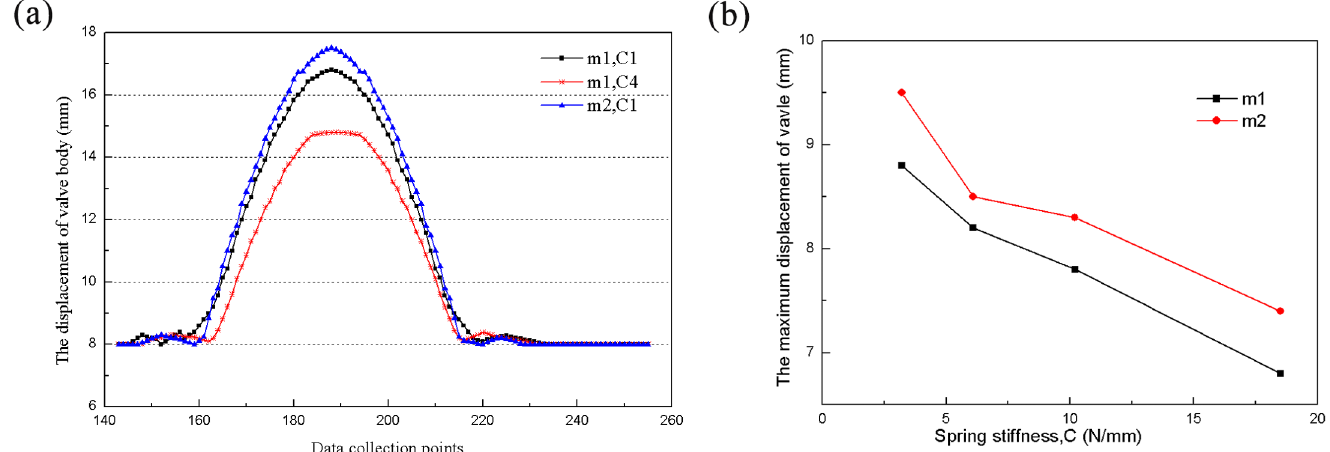
Fig 17. Curve of valve lift and maximum displacement under identical conditions. a) Valve lift curve with collection point; b) maximum displacement curve with respect to spring stiffness.